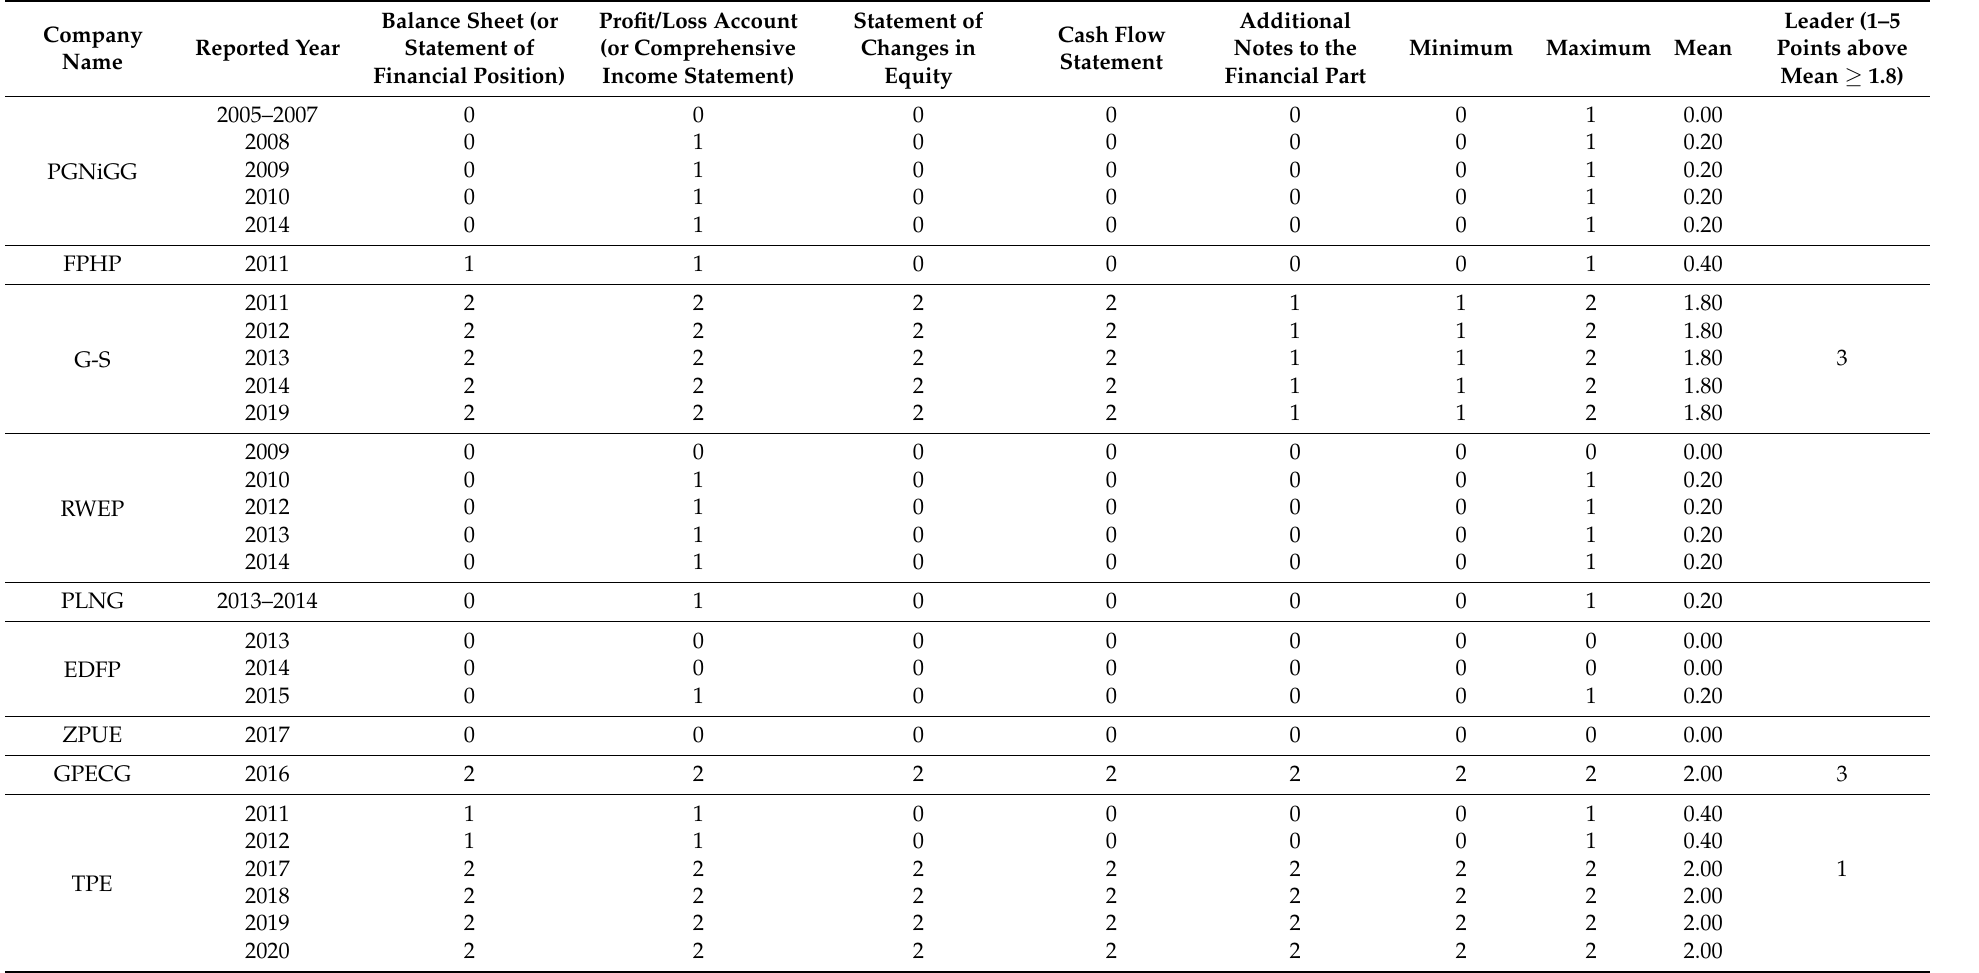
Table 5. Financial data and information in annual CSRRs and